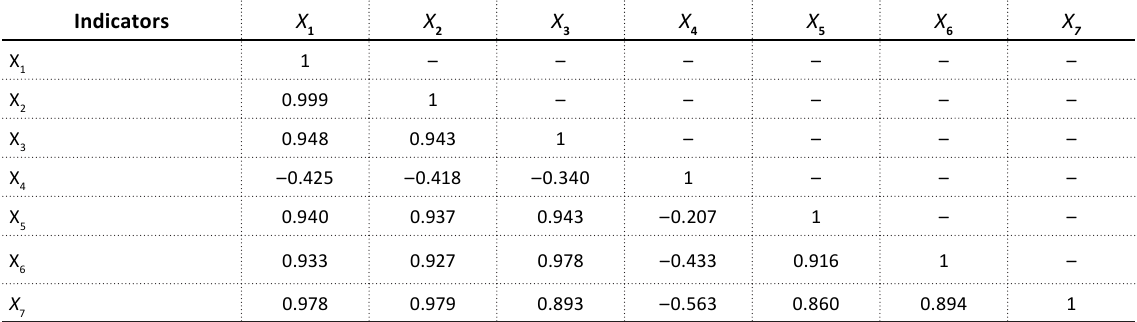
Table 2. Matrix of results of correlation analysis of indicators Х